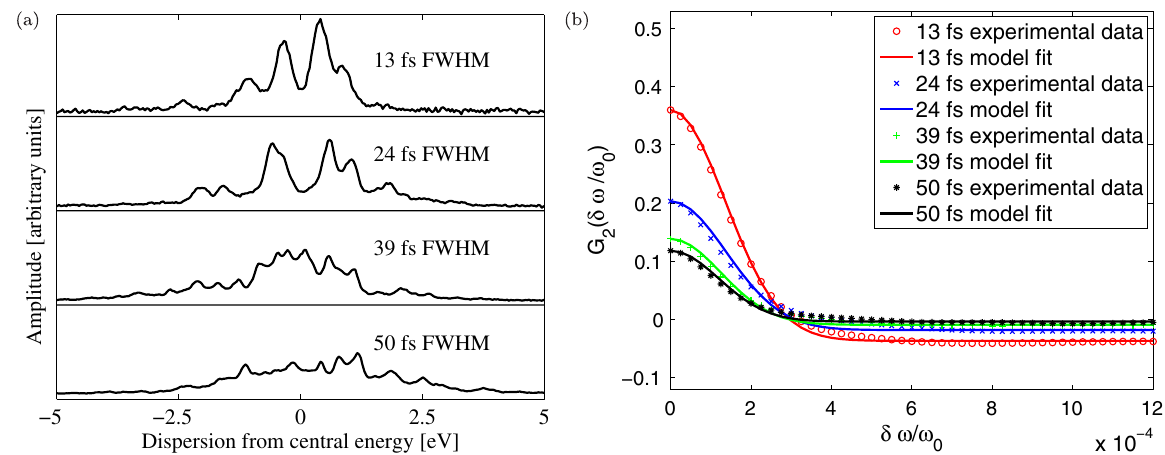
FIG. 9. Pulse duration measurement controlling the bunch length using the slotted foil. (a) Typical measured spectra. Shorter x-ray pulses present spectra with larger amplitude fluctuations. (b) Experimental G 2 function for different pulse durations (FWHM Gaussian) and fitting with the theoretical